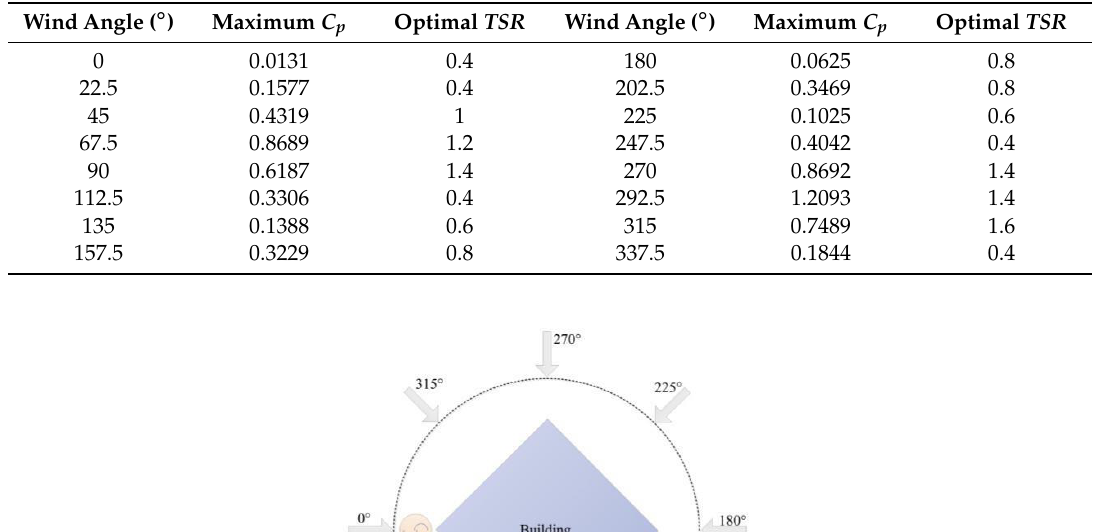
Table 4. The maximum C p and optimal TSR at each wind angle.